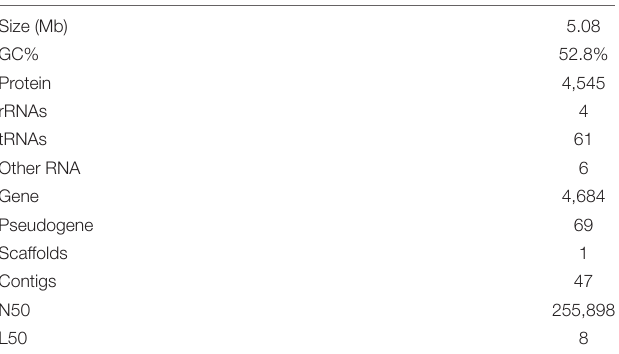
TABLE 2 | Genome characteristics of strain